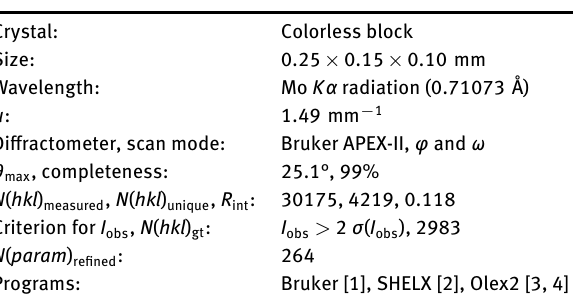
Table 1: Data collection and handling.